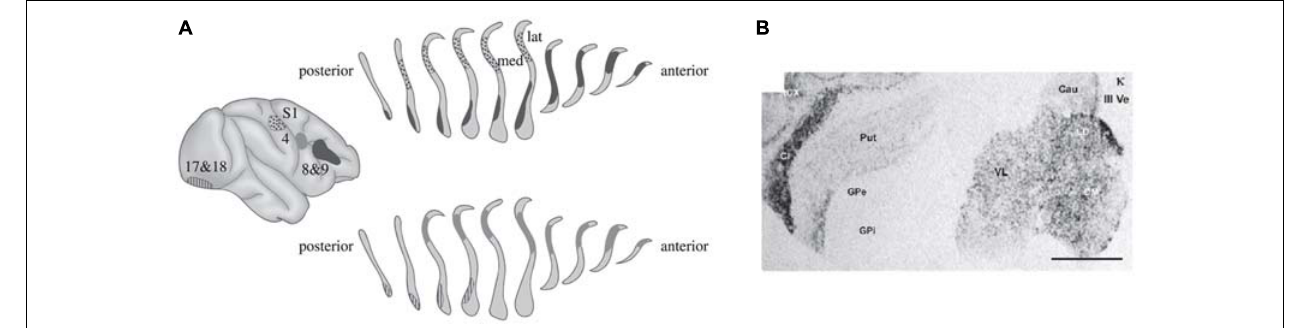
peroxidase into the cortex, and subsequently tracing the marked cells in the claustrum. Figure from Crick and Koch (2005), as modified from the original study (Phelps and LeDoux, 2005). (B) In situ hybridization signal of κ -opioid receptor mRNA.The darker the staining of the tissue, the higher the density of κ -opioid receptor mRNA, and subsequently of κ -opioid receptors. Cl: claustrum. Scale bar = 5 mm. Figure from Peckys and Landwehrmeyer